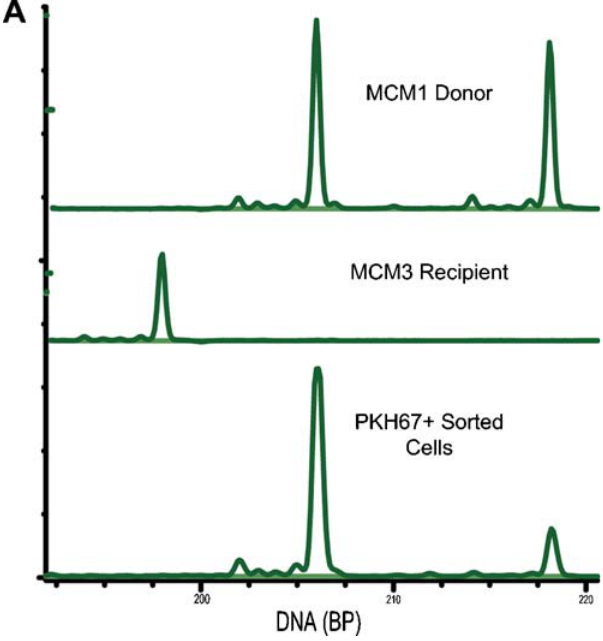
Figure 5. Allogeneic transfer cell analysis. A PKH67 + PBMC from recipient MCM3 were sorted from total PBMC by flow cytometry. We performed microsatellite analysis to demonstrate that the mircosatellite profile of PKH67 + cells in the recipient animal matched the microsatellite profile of donor MCM1.